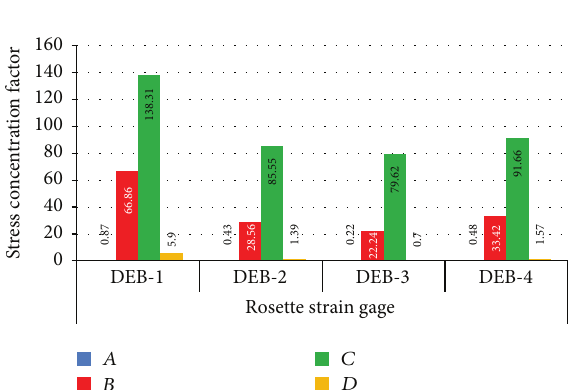
Figure 9: Stress concentration factor of